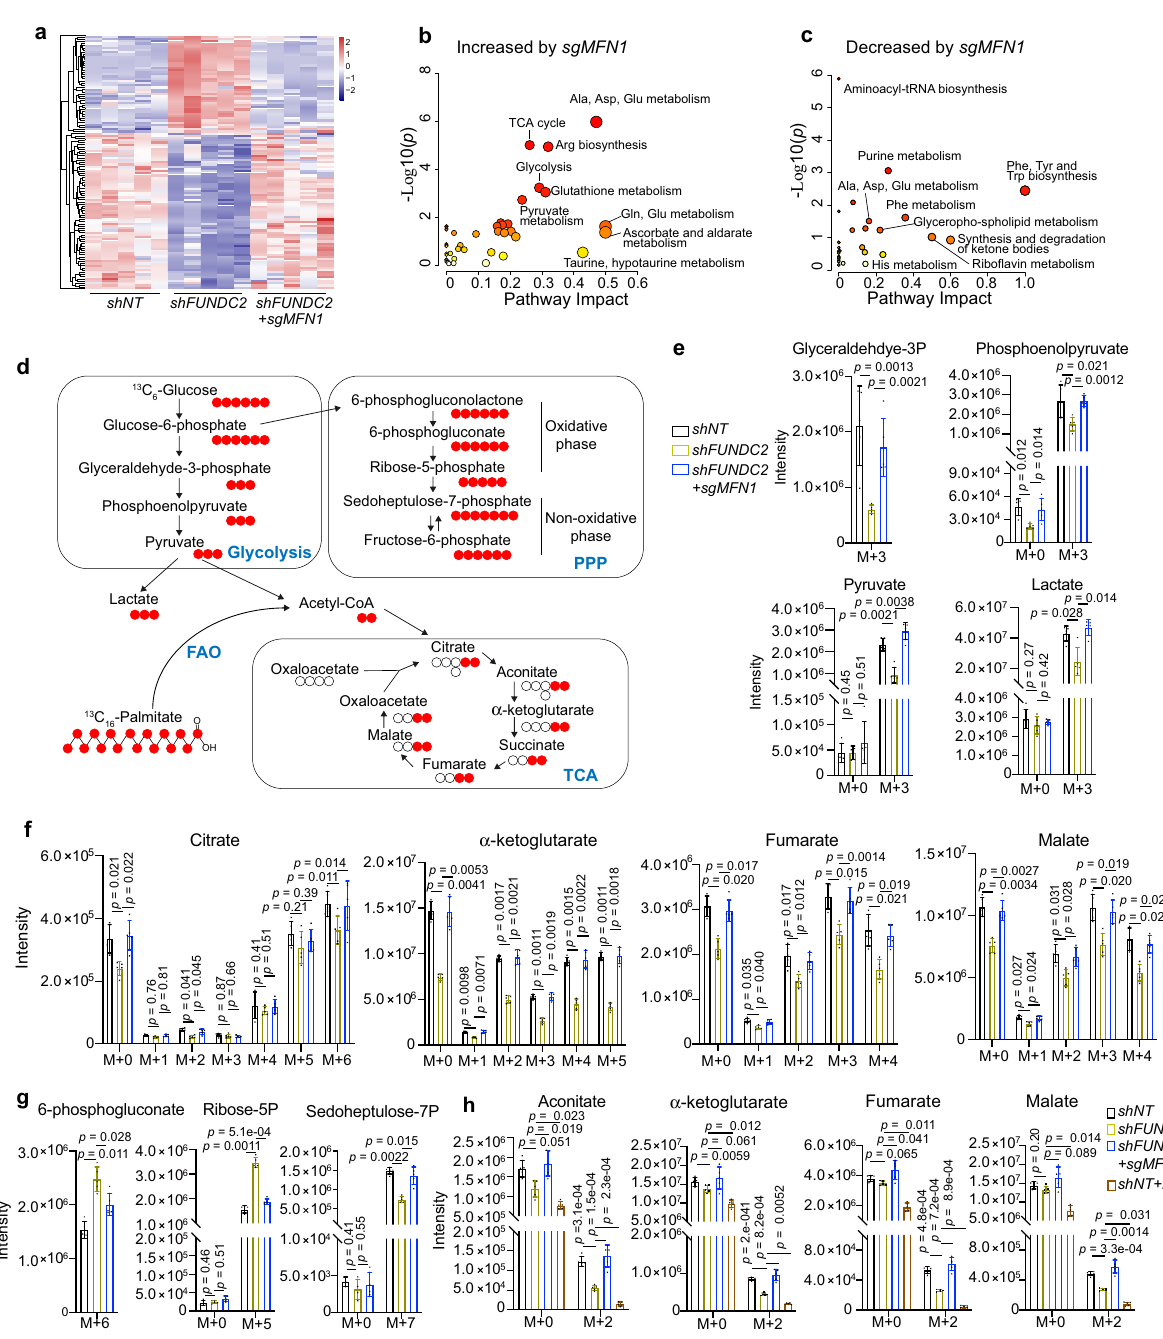
Fig. 7 FUNDC2 regulates glucose and fatty acid metabolism by inhibiting MFN1. a Heatmap cluster analysis of differential metabolites in Huh-7 cells with 5 biological replicates identi fi ed by metabolomics. b , c Pathway enrichment analysis on altered metabolites related to MFN1 knockout. d Schematic illustration of glycolysis, TCA cycle, and PPP in 13 C 6 -glucose and 13 C 16 -palmitate tracing. e , f , g Intensity of isotopomers for glycolytic intermediates ( e ), TCA cycle intermediates ( f ), and PPP intermediates ( g ) in 13 C 6 -glucose tracing. h Intensity of isotopomers for TCA cycle metabolites in 13 C 16 -palmitate tracing. Experiments were done with 5 biological replicates. Data are presented as mean ± SD. p values were calculated by two-tailed unpaired Student ’ s t - test. Source data are provided as a Source data fi